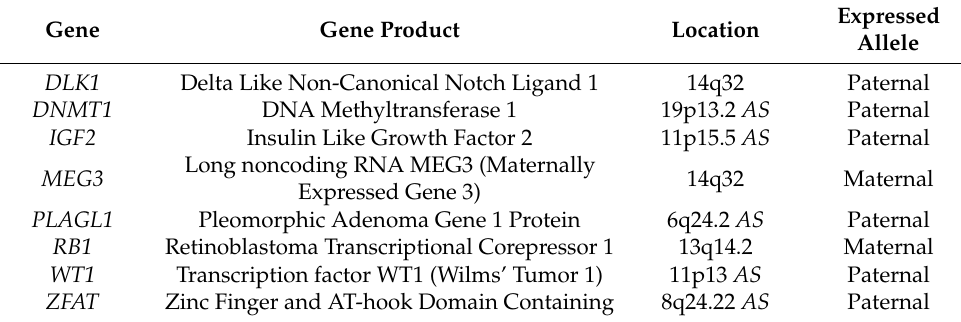
Table 1. Imprinted genes associated with multiple sclerosis